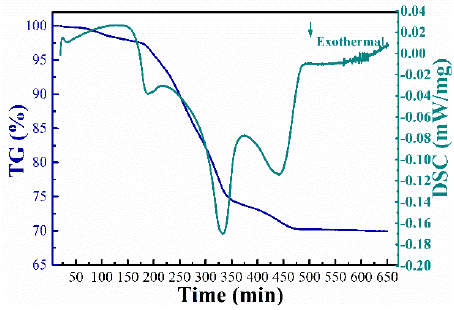
Fig. 1 3D models of (a) the p-cell unite cell and (b) the p-cell scaffold. Fig. 2 TG–DSC curves of the HA green